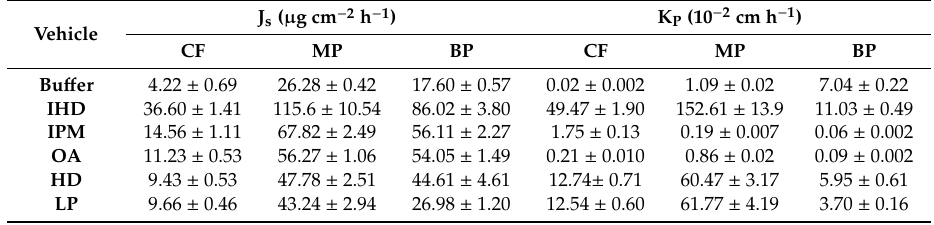
Table 1. In vitro epidermal permeation parameters, permeability coe ffi cients ( K P ) and fluxes ( J s ) for methyl paraben (MP), butyl paraben (BP) and ca ff eine (CF) from di ff erent oily vehicles and phosphate bu ff er pH 7.0. Data represent mean ± sd ( n = 4 or 5).